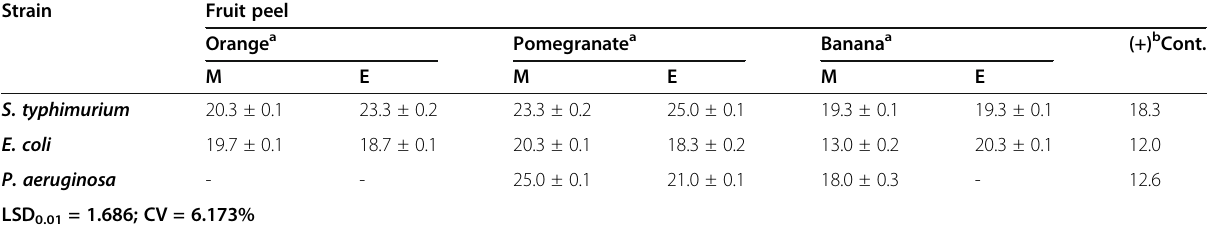
Table 2 Inhibition zones of both methanolic and ethanolic extracts of the used fruit peels against some G − food pathogens Strain